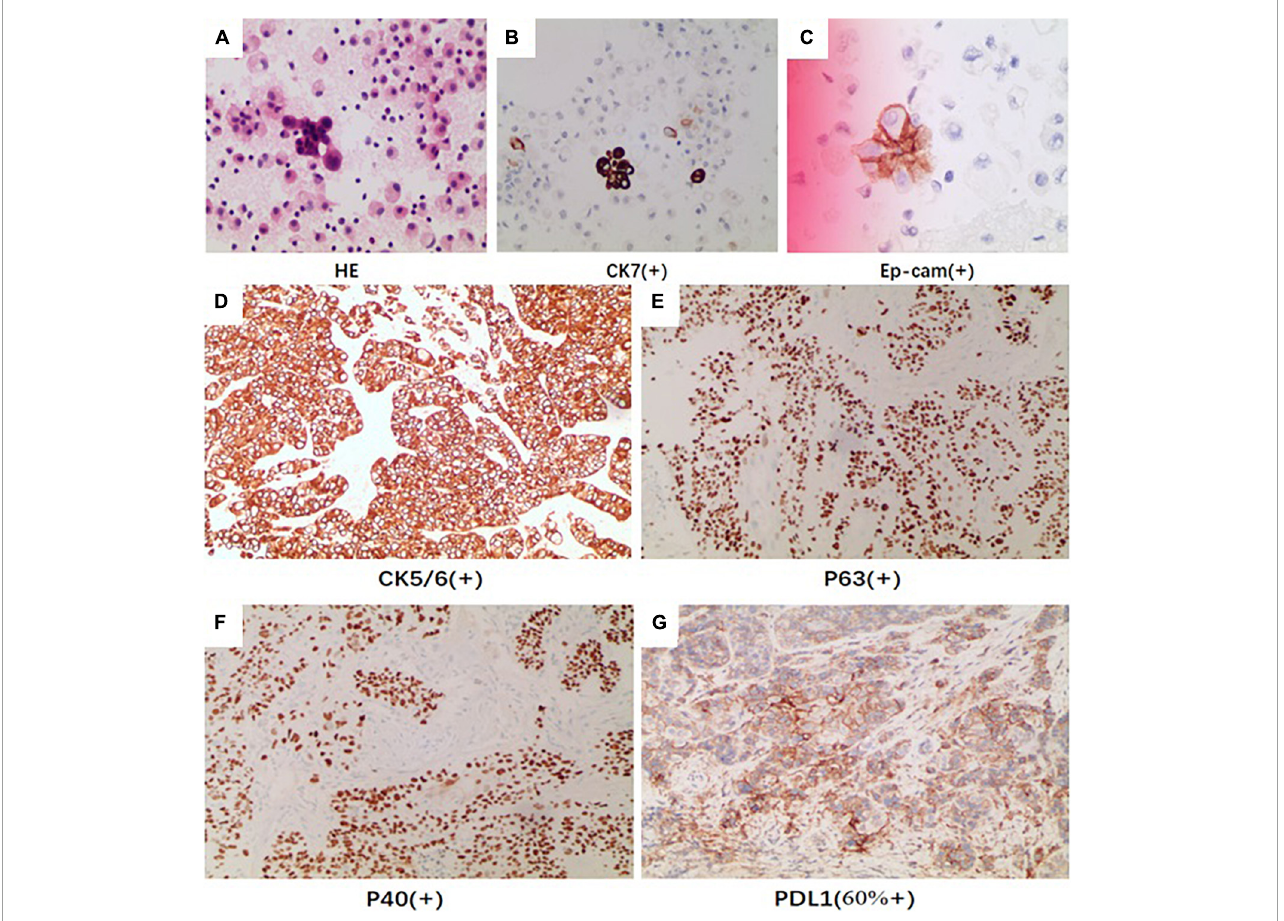
FIGURE3 The pericardiac fluid by HE revealed (A) exfoliated tumor cells with (B) CK7 (positive) and (C) Ep-cam (positive). The immunohistochemical analysis of pathologic tissue by percutaneous lung puncture showed (D) CK5/6 (positive), (E) P40 (positive), (F) P63 (positive), and (G) PDL1 (positive).